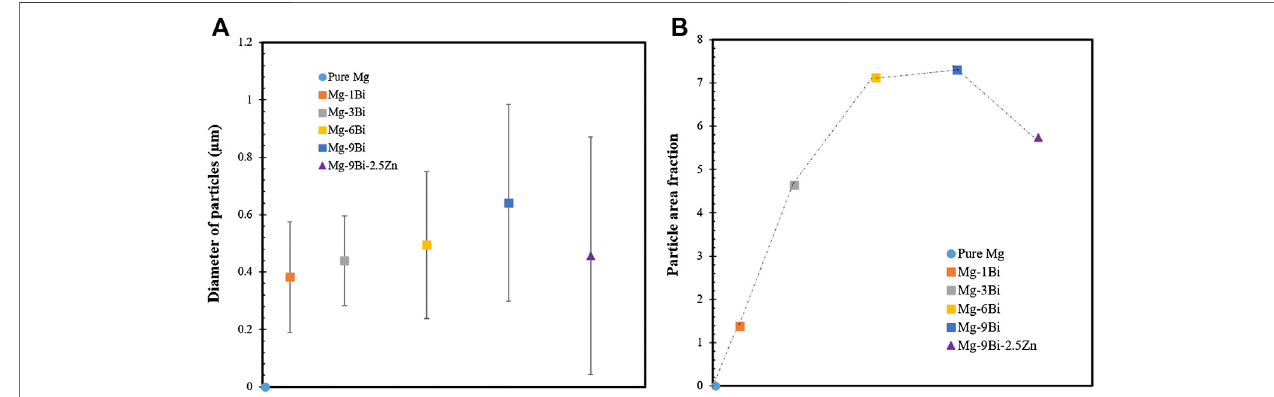
FIGURE 6 | (A) Diameter and (B) area fraction of Mg 3 Bi 2 particles in pure Mg and alloys studied in the present work. ImageJ is used for analysis based on SEM images. The error bars represent the standard deviation. The dashed line is used for guiding the eyes.